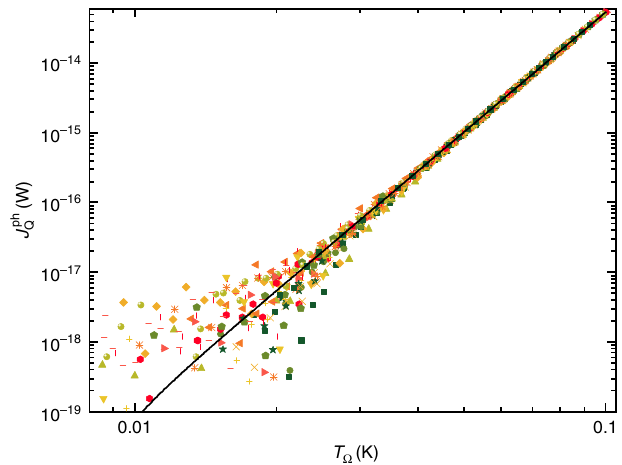
Fig. 5 Electron – phonon heat transfers. Symbols represent the fl ow of heat J ph Q from the electrons within the metallic island to the phonons at T ’ 8 mK . Different symbols represent data points from different con fi gurations N 2 f 2 ; 3 ; 4 g and τ 2 f 0 ; 1 g , including measurements performed in two different cooldowns. All the data collapse on J ph Q ¼ 2 : 752 ´ 10 (cid:3) 8 ð T 5 : 709 Ω (cid:3) T 5 : 709 Þ W (continuous